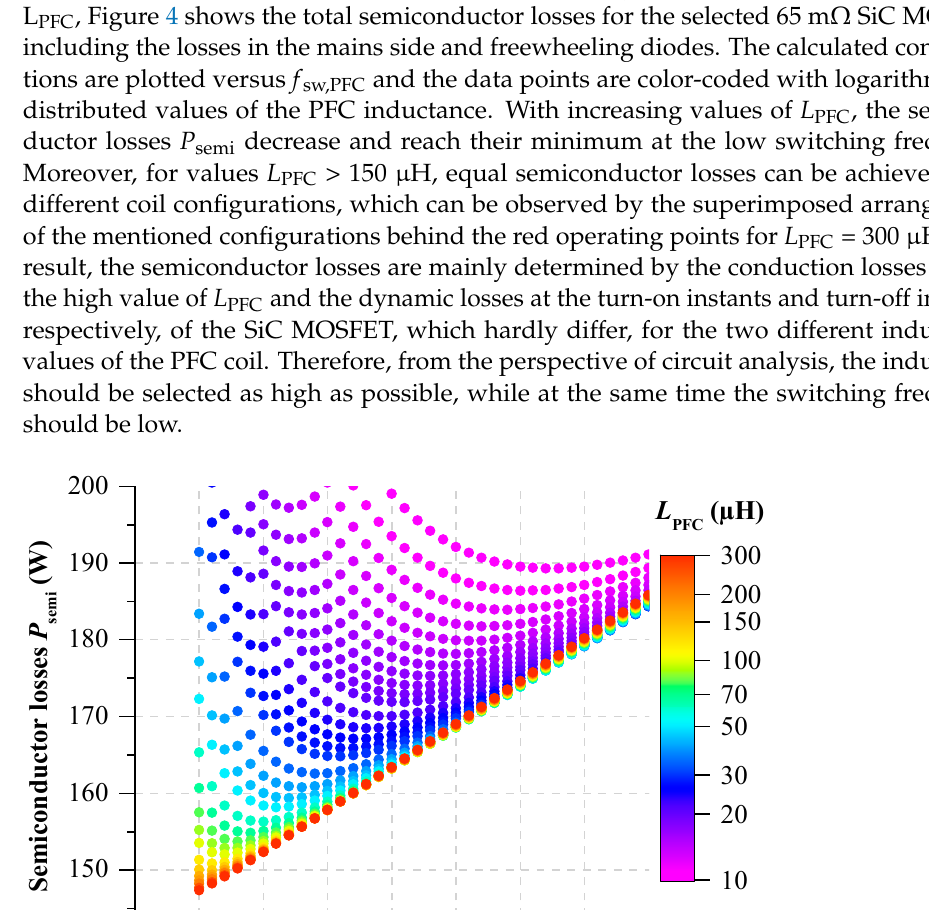
Figure 5. Toroidal core with the geometrical designations for the analytical calculation.